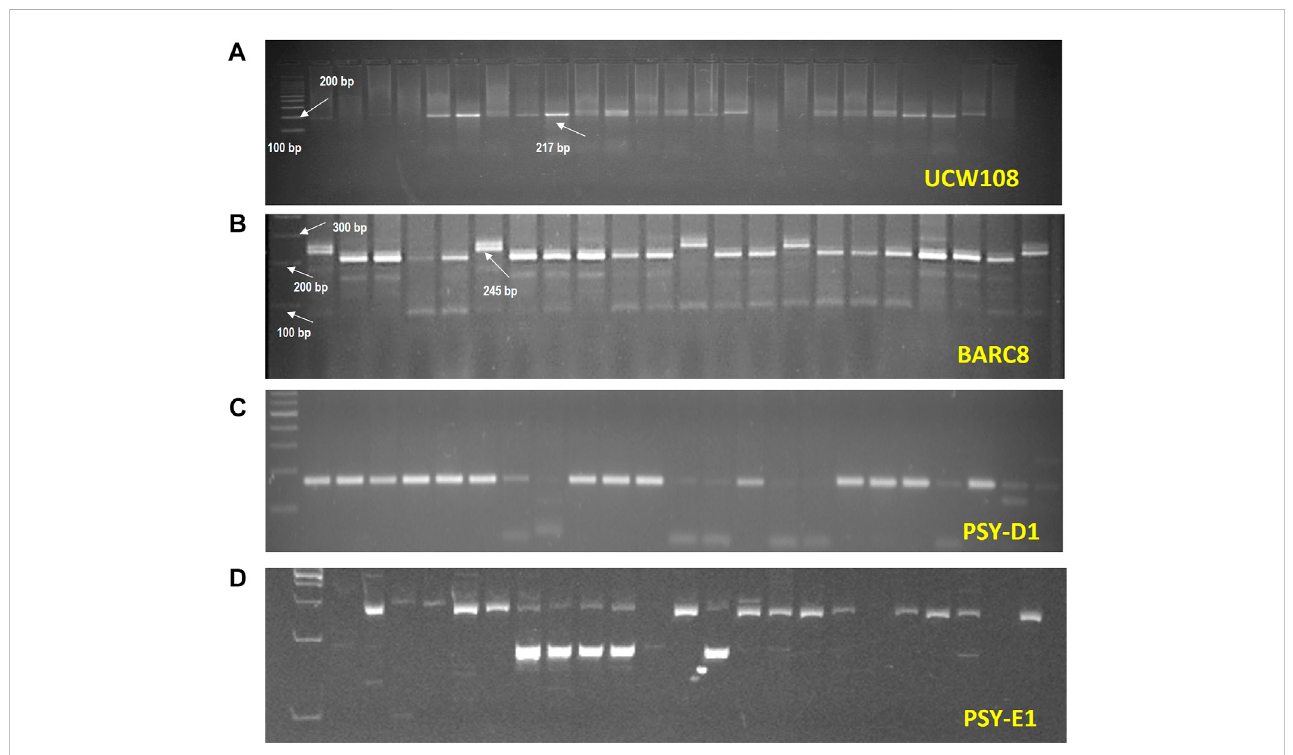
FIGURE 3 Ampli fi cation of markers, (A) . UCW108, (B) . BARC8, (C) . PsyD1 and (D) . PsyE1 in the